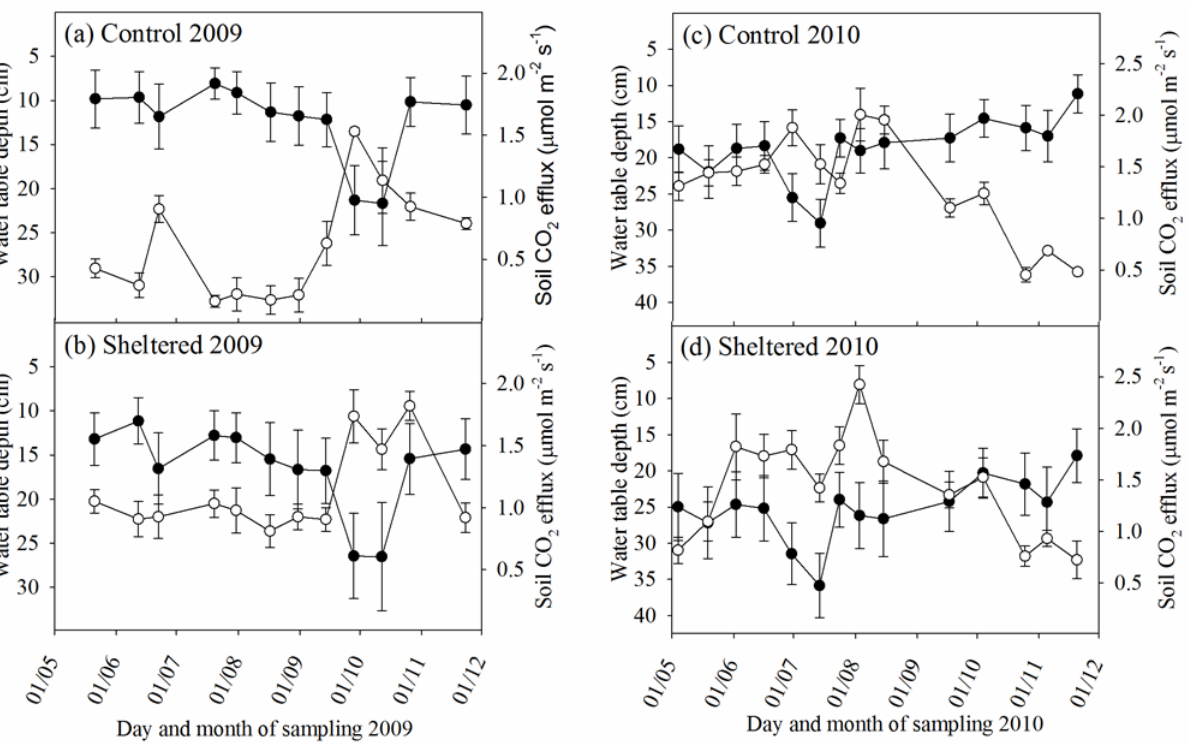
Figure 4. Water table depth (cm) ( • ) and soil CO 2 efflux (µmol m -2 s -1 ) (○) in control and sheltered treatments (± SEM) in 2009 (a, b) and 2010 (c, d).